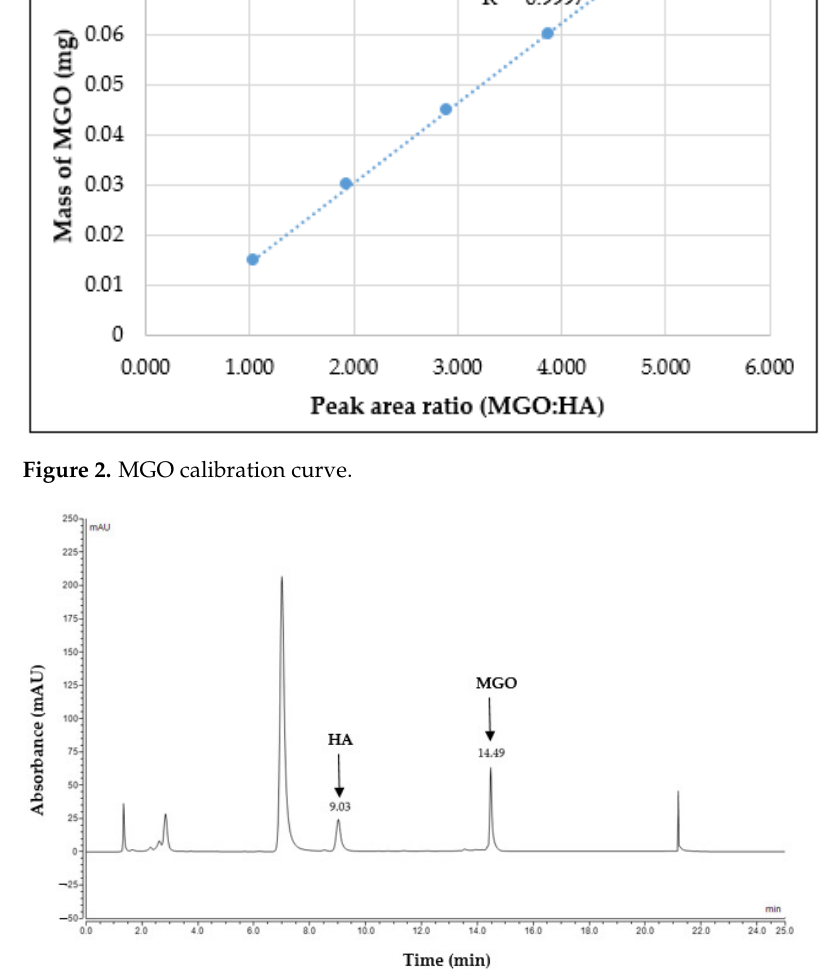
Figure 3. HPLC chromatogram of MGO standard (0.015 mg/mL) and HA internal standard (0.075 mg/mL) at λ = 263 nm.